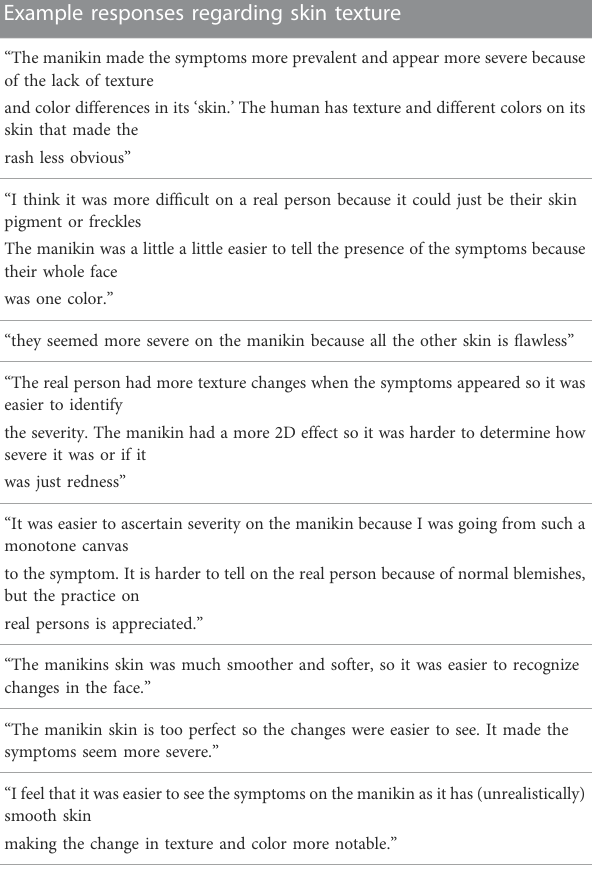
TABLE 4 Descriptive Statistics for severity ratings.